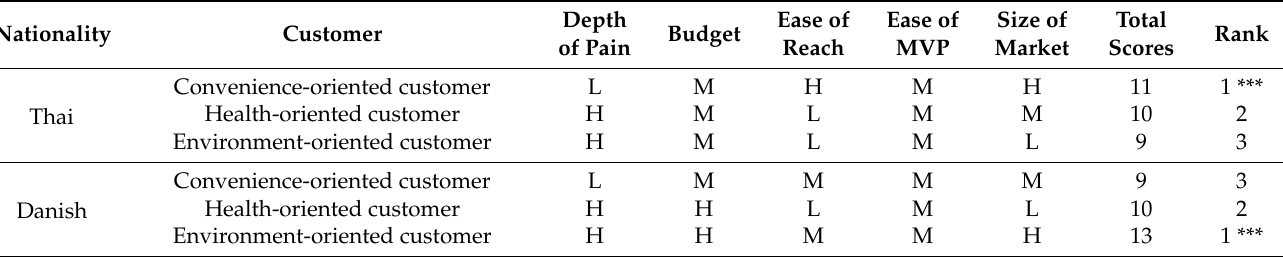
Table 3. Segmentation matrix of Thai and Danish